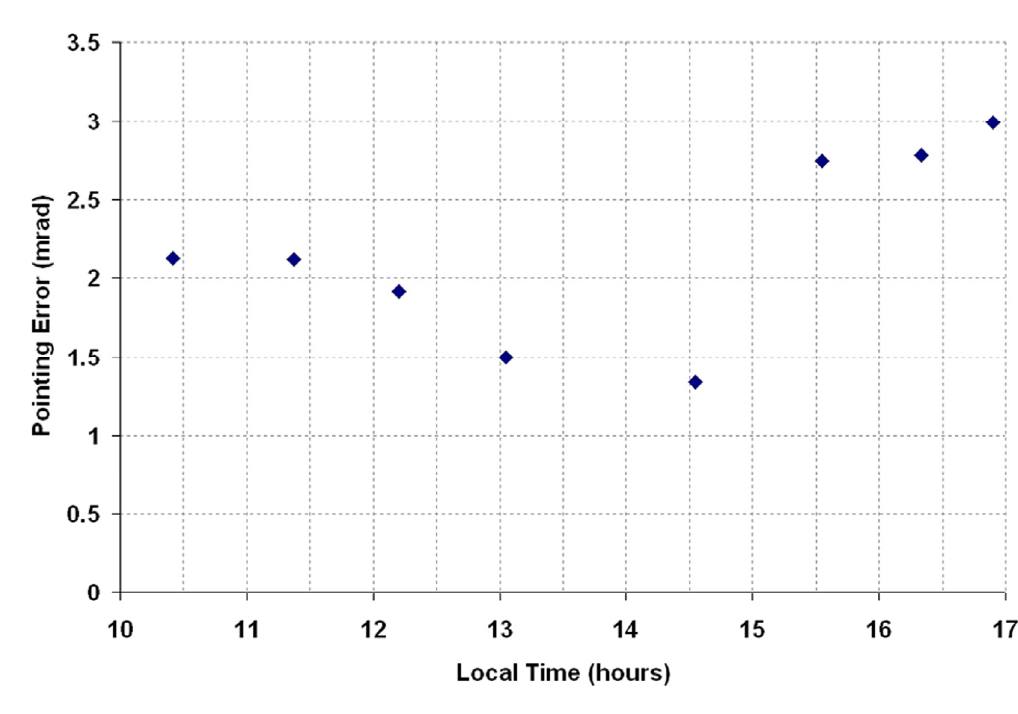
Figure 7. The plot of pointing error (mrad) versus local time (hours) for the parameters, i.e., φ = –0.1°; λ = 0°; and ζ = –0.5°, on 16 January